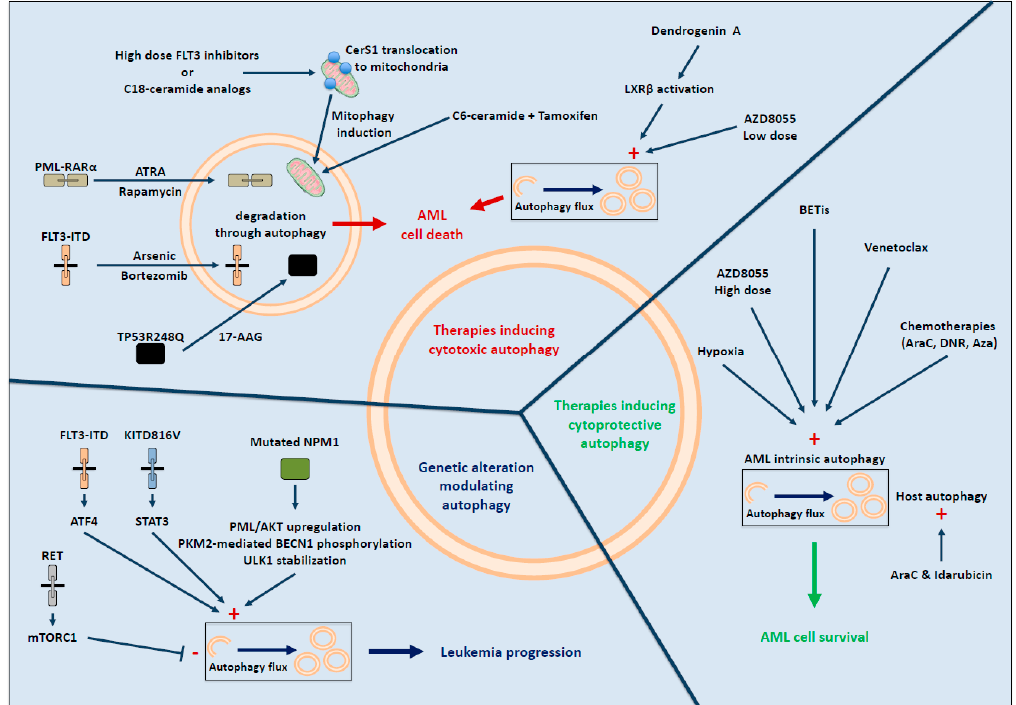
Figure 2. Contribution of autophagy in AML development and treatment. FLT3 (FMS-like tyrosine kinase 3) is a receptor tyrosine kinase commonly mutated in AML patients. The most frequent mutations in this gene occur via internal tandem duplication ( FLT3- ITD) in the juxtamembrane domain or through point mutations, usually involving the tyrosine kinase domain ( FLT3- TKD). Both mutations result in FLT3 constitu- tive activation, leukemic cell proliferation, and survival. FLT3 -ITD confers poor prognosis outcomes in AML patients [30]. Interestingly, FLT3-ITD activity has been shown to increase basal autophagy in AML cells, which is required for AML cell proliferation in vitro and for leukemic cell survival in a xenograft mouse model. ATF4 (activating transcription factor 4) was identified as an essential mediator of FLT3-ITD-induced autophagy. Moreover, downregulation of autophagy or ATF4 inhibited AML cell proliferation and improved mice survival. In addition, autophagy inhibition in FLT3-TKD cells, which are resistant to the FLT3 inhibitor quizartinib (AC220), is also able to inhibit proliferation both in vitro and in vivo